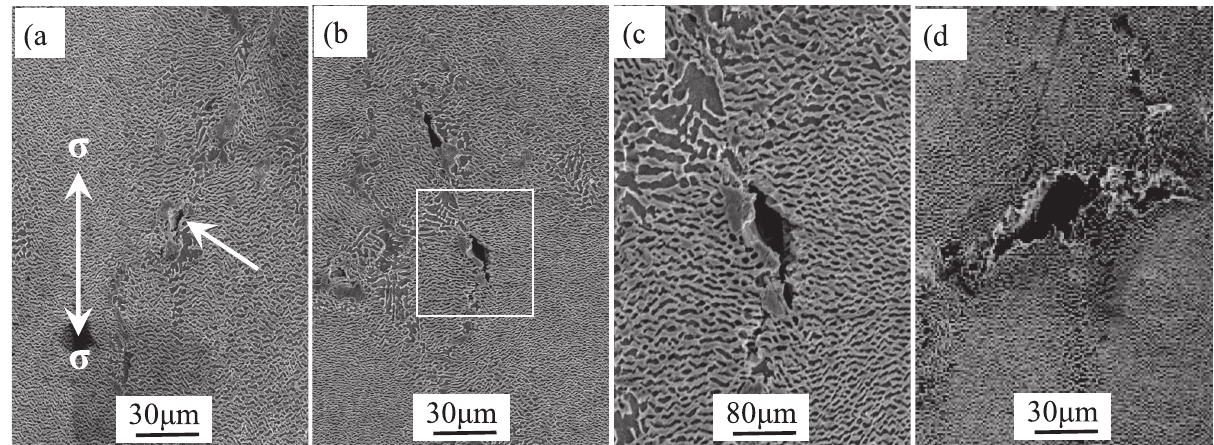
Fig. 9: Surface morphology of the sample after being crept for different time at 1040 °C/137 MPa. (a) Crept for 65 h, (b) crept for 75 h, (c) amplified morphology of Fig. 9(b), (d) crept for 92 h up to